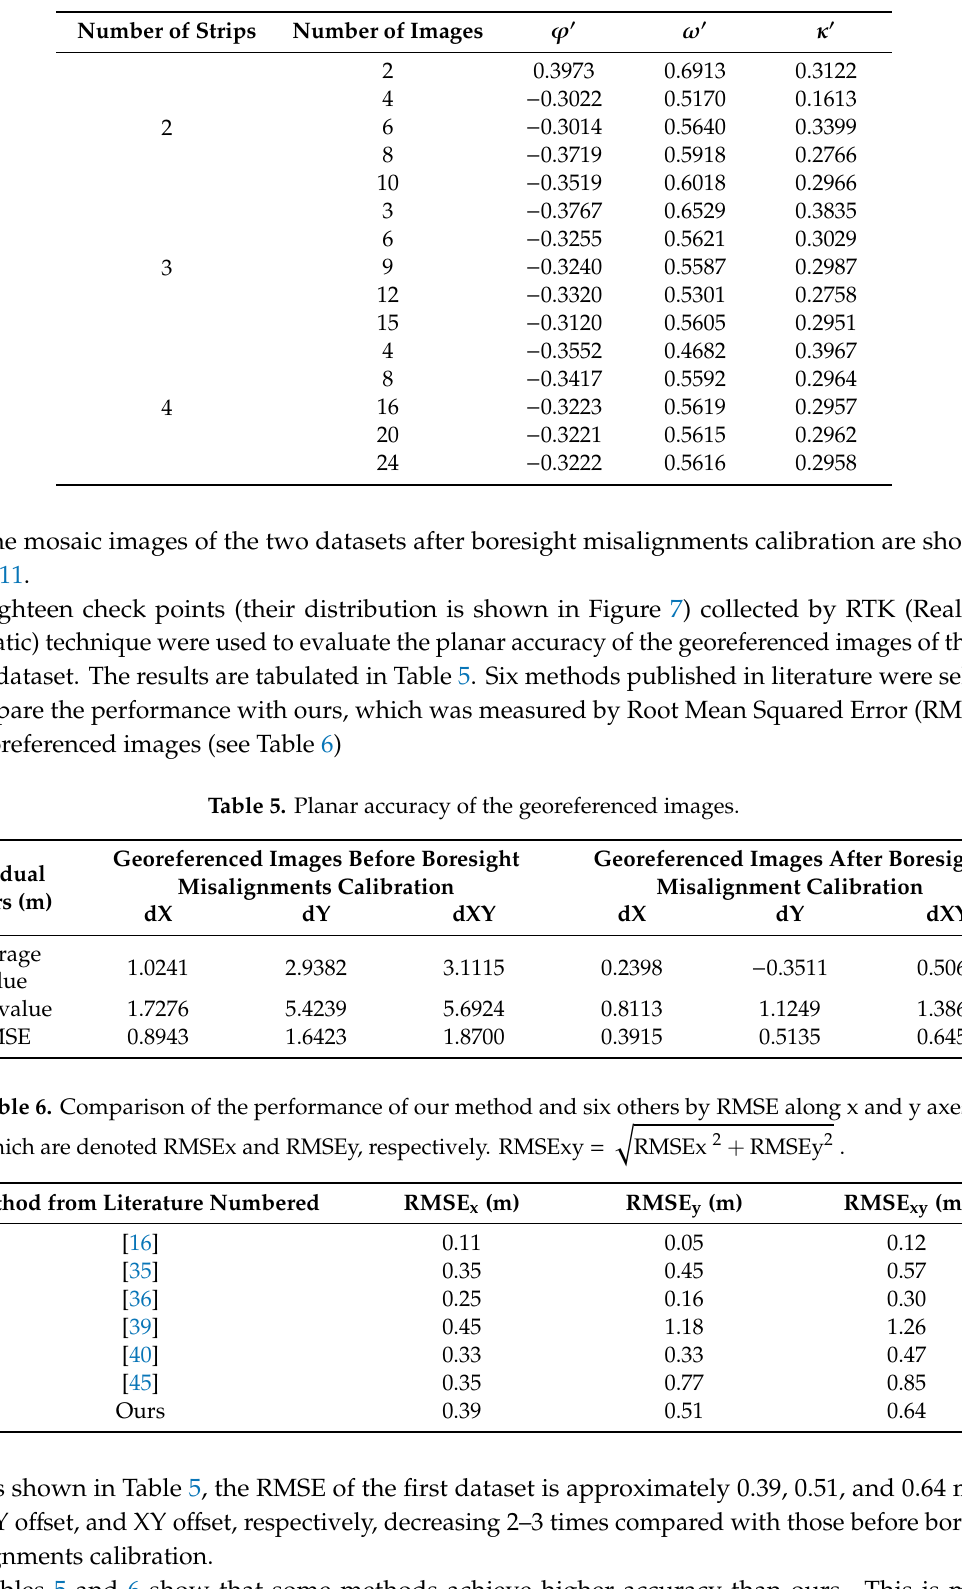
Table 4. Misalignments (in degrees) calibrated by di ff erent numbers of images.